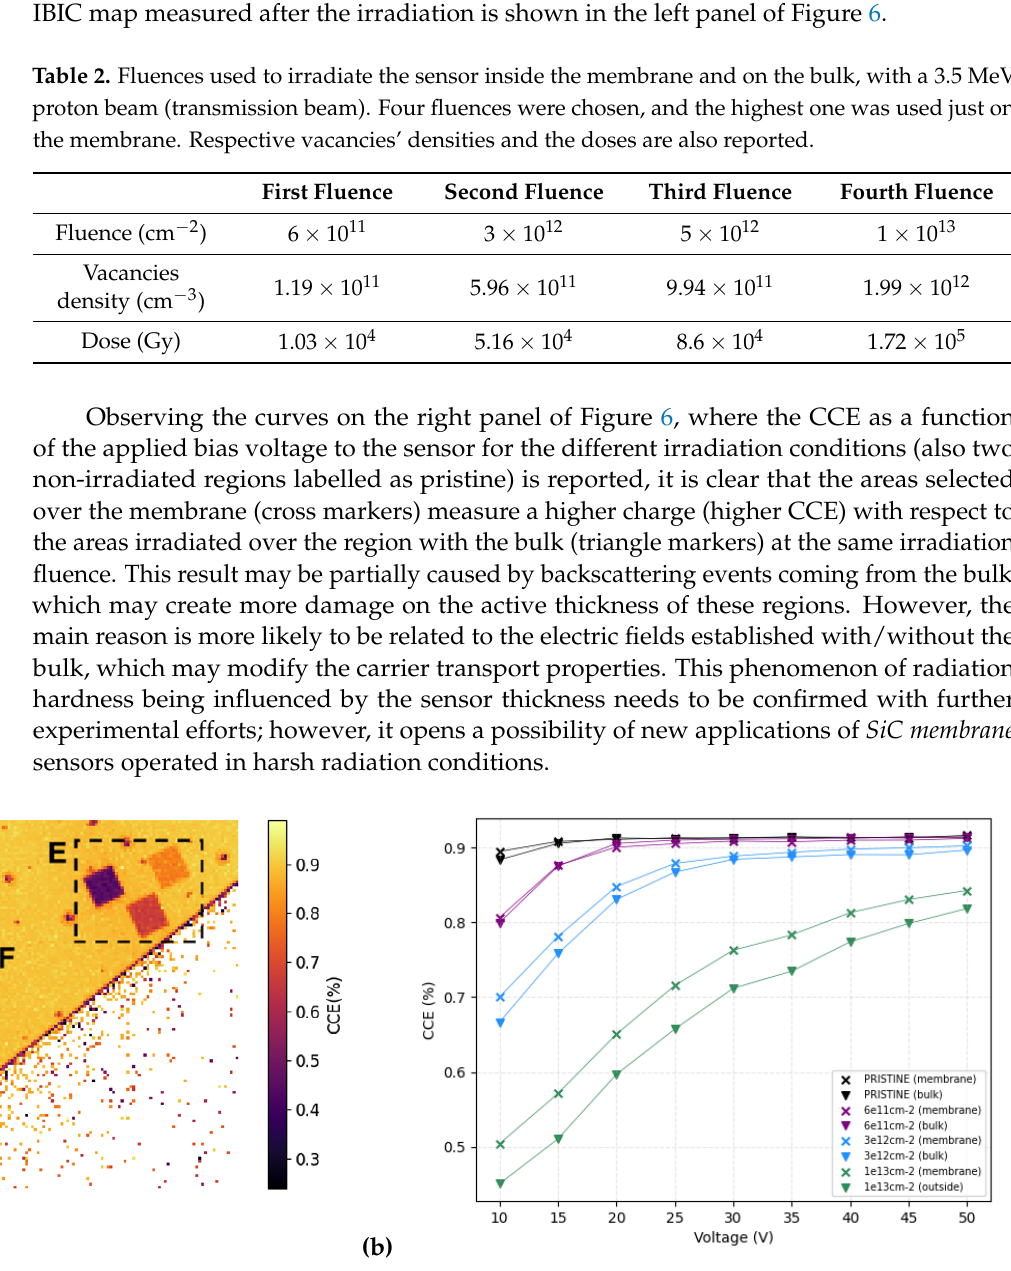
Figure 6. ( a ) IBIC map acquired at 10 V on the sensor region containing the damaged areas. The framed areas in the E region were in the bulk, and the F areas were on the membrane. The colorbar on the right shows the CCE values. ( b ) Charge collection efficiencies as a function of the applied bias voltage. Different colors indicate different irradiance fluences, triangle markers indicate E regions, and crosses indicate F